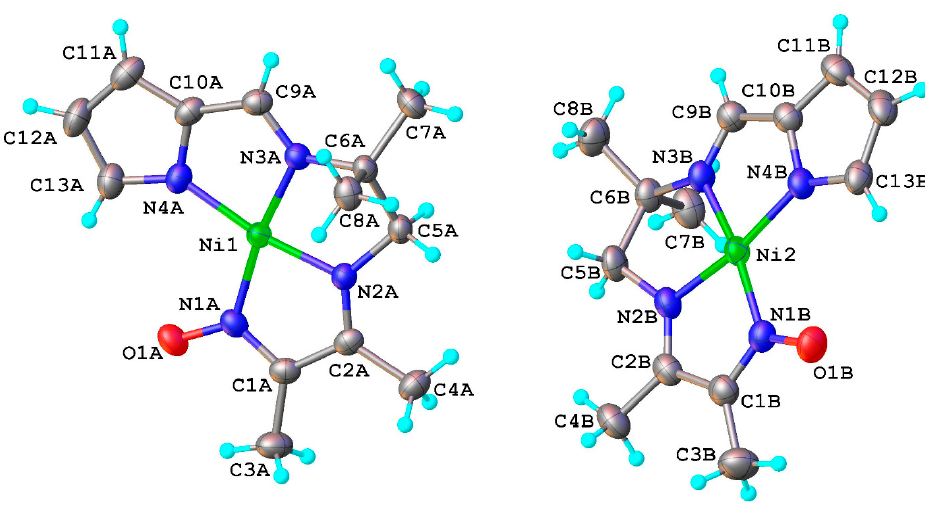
Figure 1. View of the asymmetric unit in the crystal structure 1 with atom labeling scheme and thermal ellipsoids at 40% probability level. Selected bond lengths (Å) and angles (°): Ni1–N1A